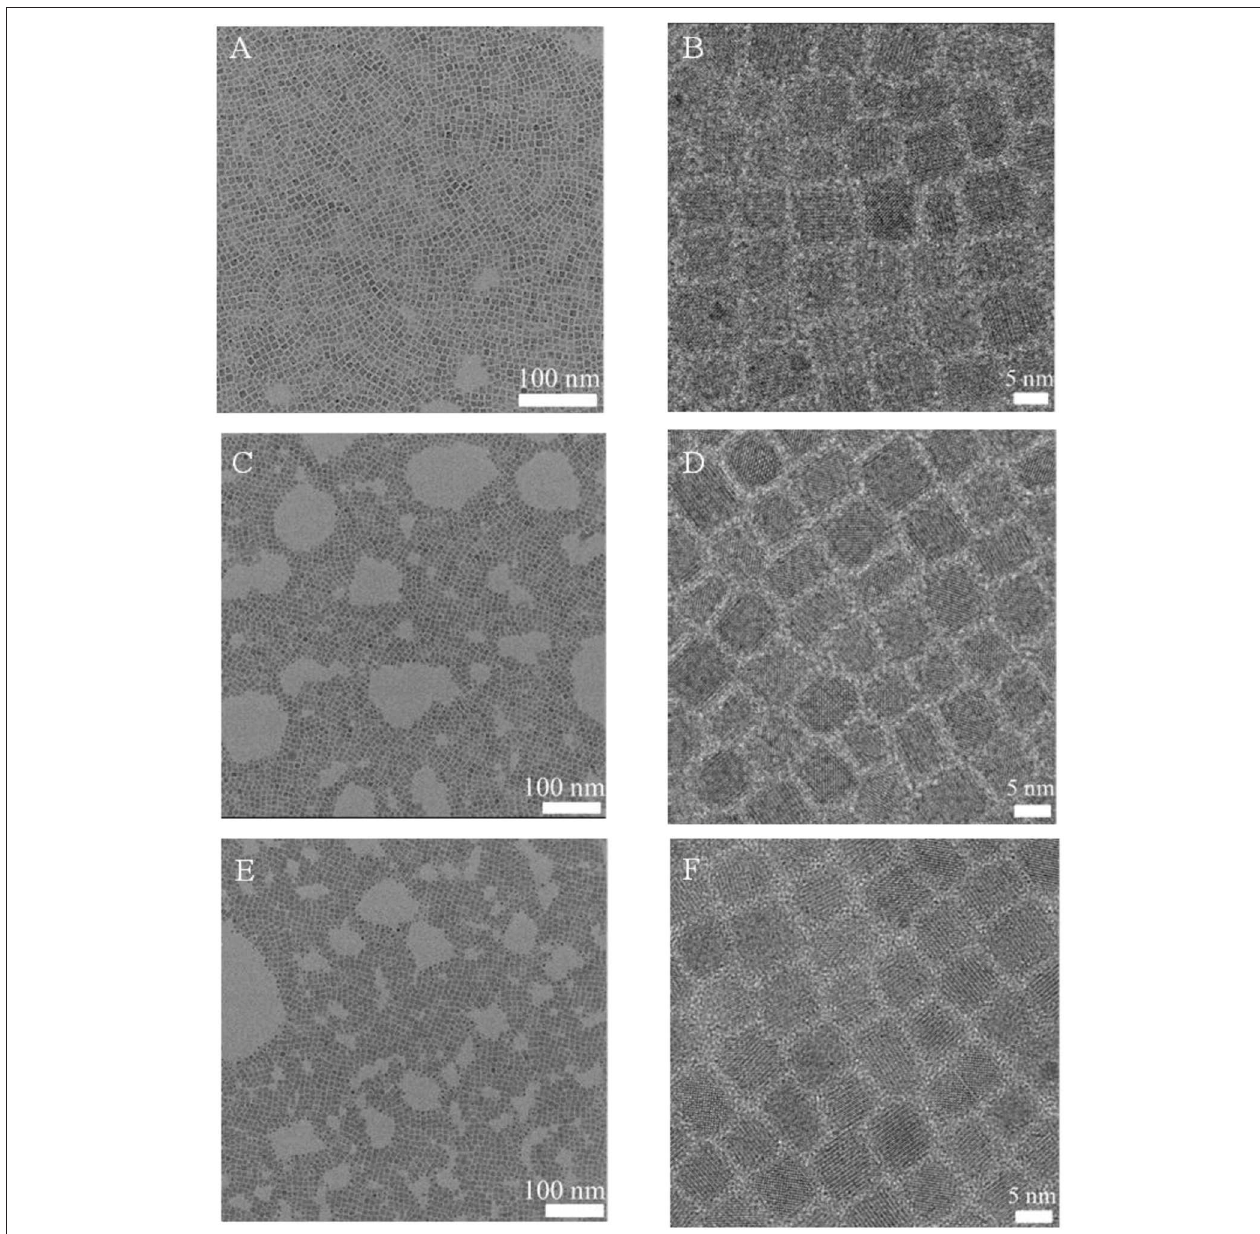
FIGURE 6 | TEM images of CsPbBr 3 NCs (A,B) , DDAS-CsPbBr 3 NCs (C,D) , and BPO-DDAS-CsPbBr 3 NCs (E,F) with different magnification.